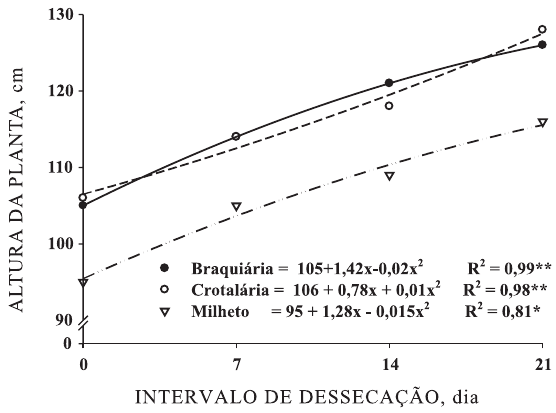
Figura 8. Altura da planta de milho, em função do intervalo de dessecação, em diferentes espécies de plantas de